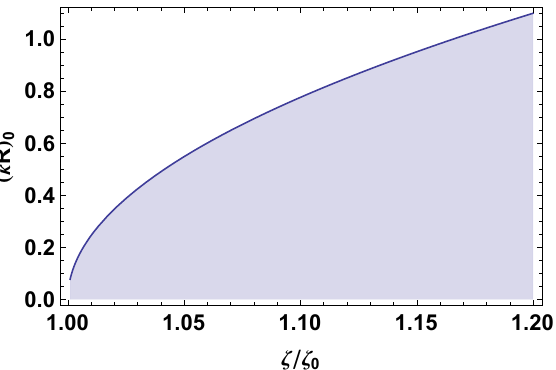
Figure 2. The critical parameter ( κ R ) 0 where the mass flow changes the sign vs. the ζ potential. The shaded area is the region where the flow reverses the